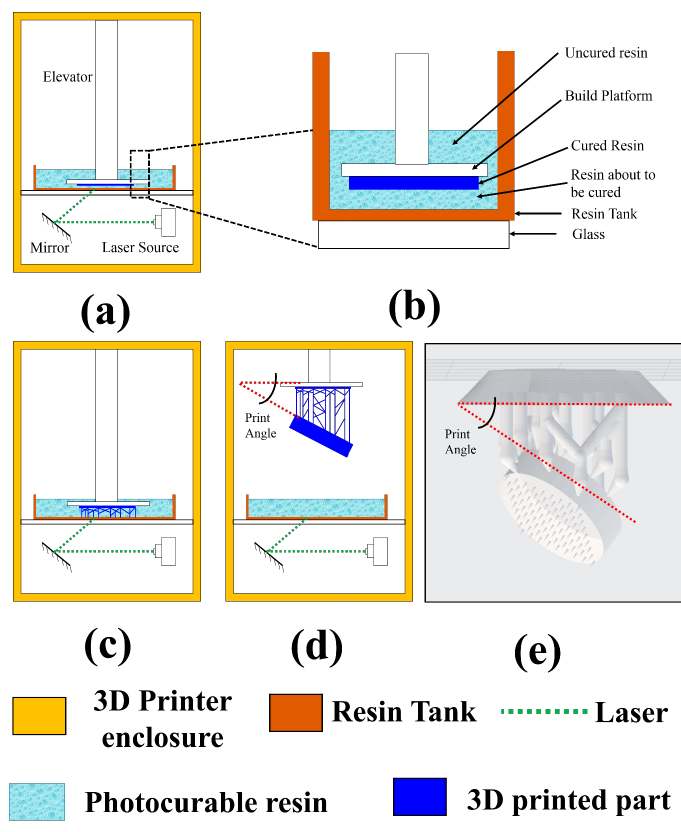
Figure 4. Schematic of our benchtop based 3D stereolithography (SLA) printing with its key components and various printing stages—( a ) Stage 1: Printing of the base support structure; ( b ) expanded view of the various interfaces in a typical benchtop SLA 3D printer; ( c ) stage 2: Printing of the scaffolds for supporting the actual 3D printed geometry; ( d ) stage 3: Final 3D printed device